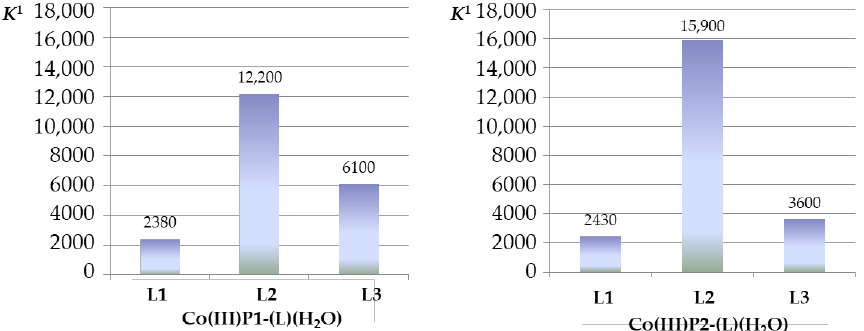
Figure 12. S tability constants ( K 1 and K 2 , (М –1 ) of the micellized mono -axial porphyrinates Со(III)P1-(L)(H 2 O)] Mc and [Со(III)P2-(L)(H 2 O)] Mc in phosphate buffer (pH 7.4) at 25 ° С.